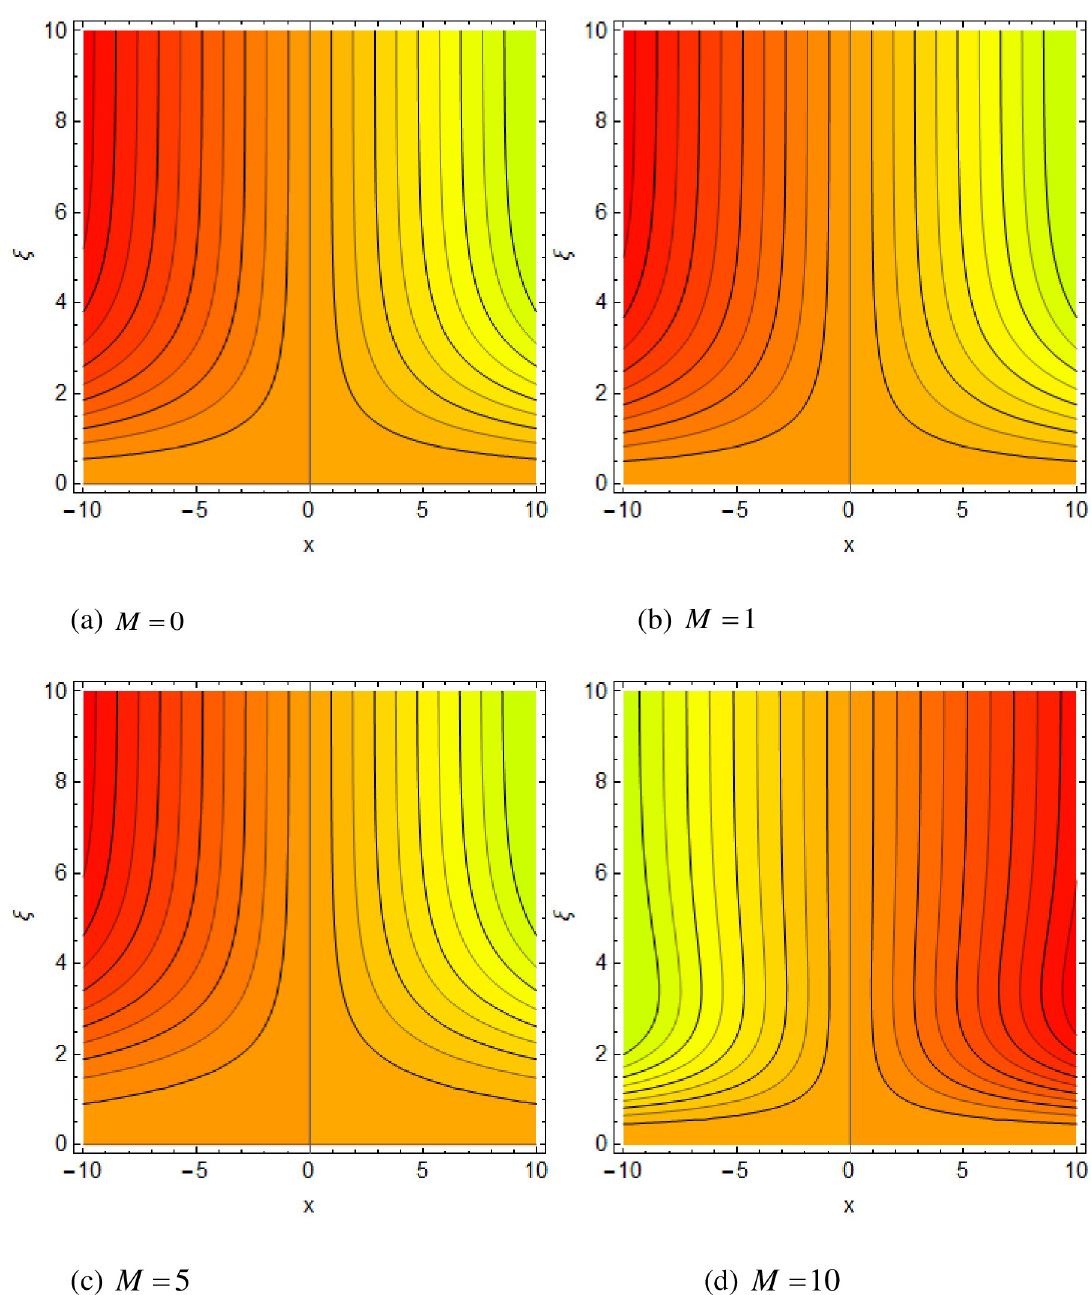
Fig 11. (a–d) Impact of magnetic field on streamlines when Pr = 5.0, λ = 0.5, Da = 1.0, Ec = 0.1, Nb = 0.2, Nt = 0.2, Le = 0.3, Nr = 0.2, Rd = 1.3 and Ra = 10 3